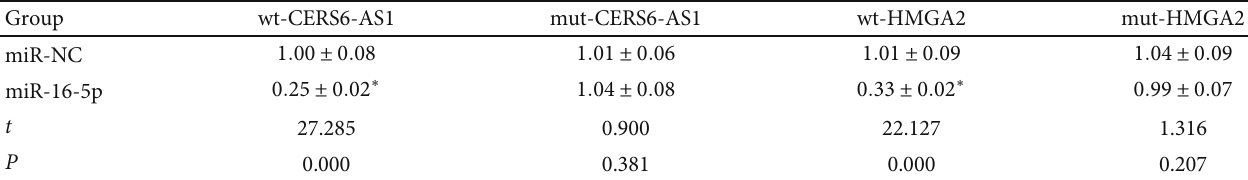
Table 3: Double luciferase report experiment ( (cid:1) x ± s , n = 9 ).